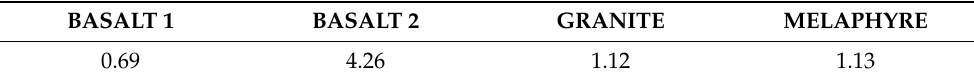
Table 1. Fine particle content (in %) in the tested aggregates (particle grade below 0.063 mm).